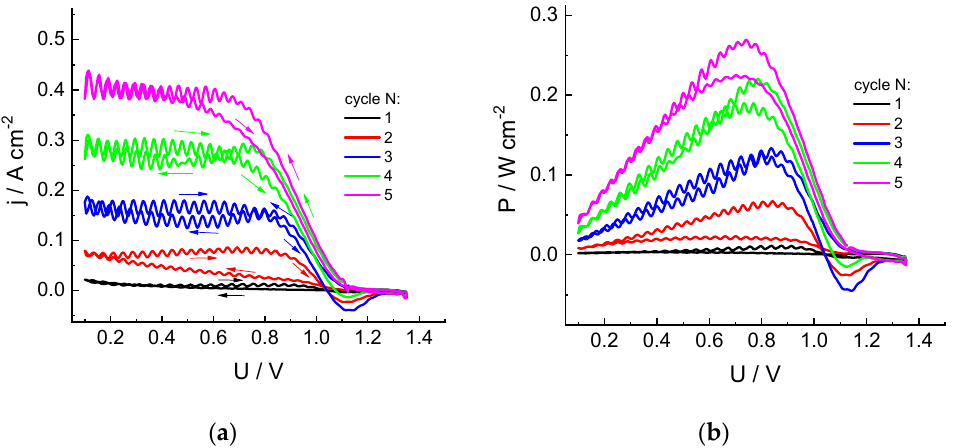
Figure 1. Dependences of the cathodic current density ( a ) and specific power ( b ) of the discharge on cell voltage for five successive cycles of voltage sweep from OCV to 0.1 V for the hydrogen-chlorate MEA: Nafion 212 membrane (working area: 4 cm 2 ); cathode: three sheets of carbon paper (SIGRACET 39AA): anode: GDL Freudenberg H24C5 С 13, Pt 0.47 mg/cm 2 : catholyte composition: 1 M NaClO 3 + 4 M H 2 SO 4 ; circulation rates: 54 mL/min (solution), 2.5 dm 3 /h (H 2 ); voltage sweep rate: 5 mV/s. The first scan starts from the fresh solution in the reservoir.